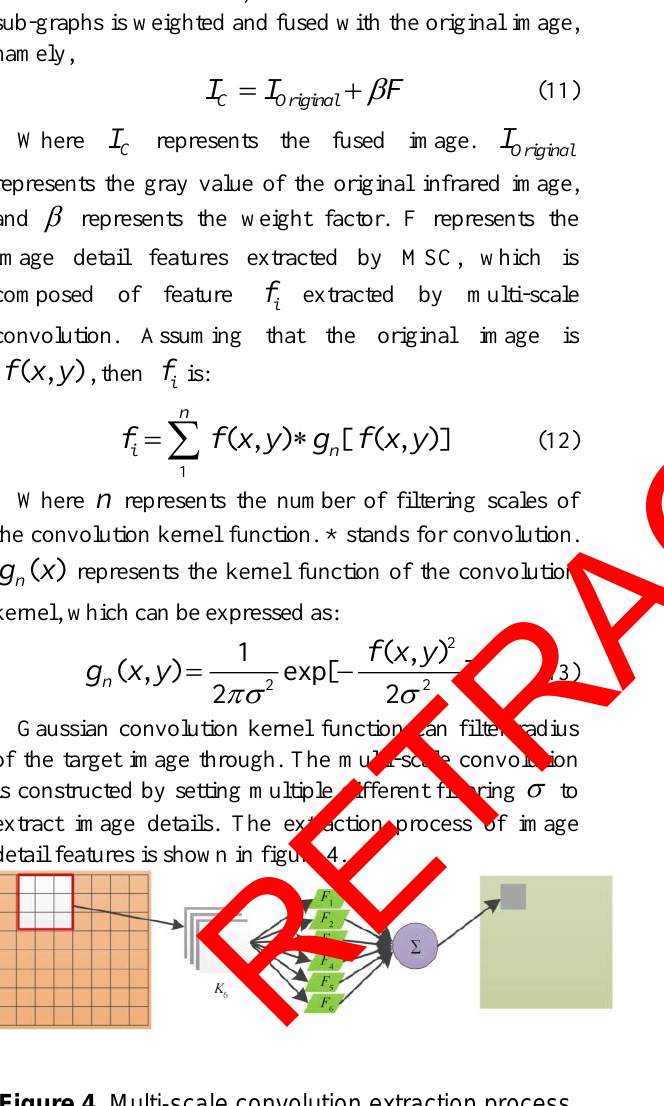
Figure 4. Multi-scale convolution extraction process of image details